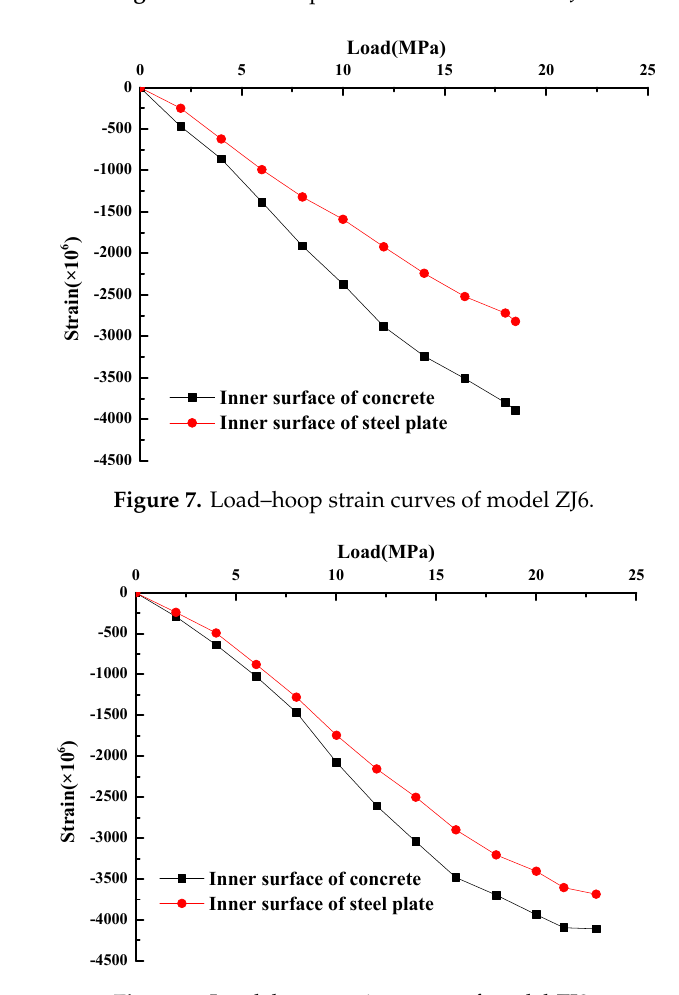
Figure 5. Load–hoop strain curves of model ZJ1. Figure 6. Load–hoop strain curves of model ZJ4. Figure 6. Load–hoop strain curves of model ZJ4.